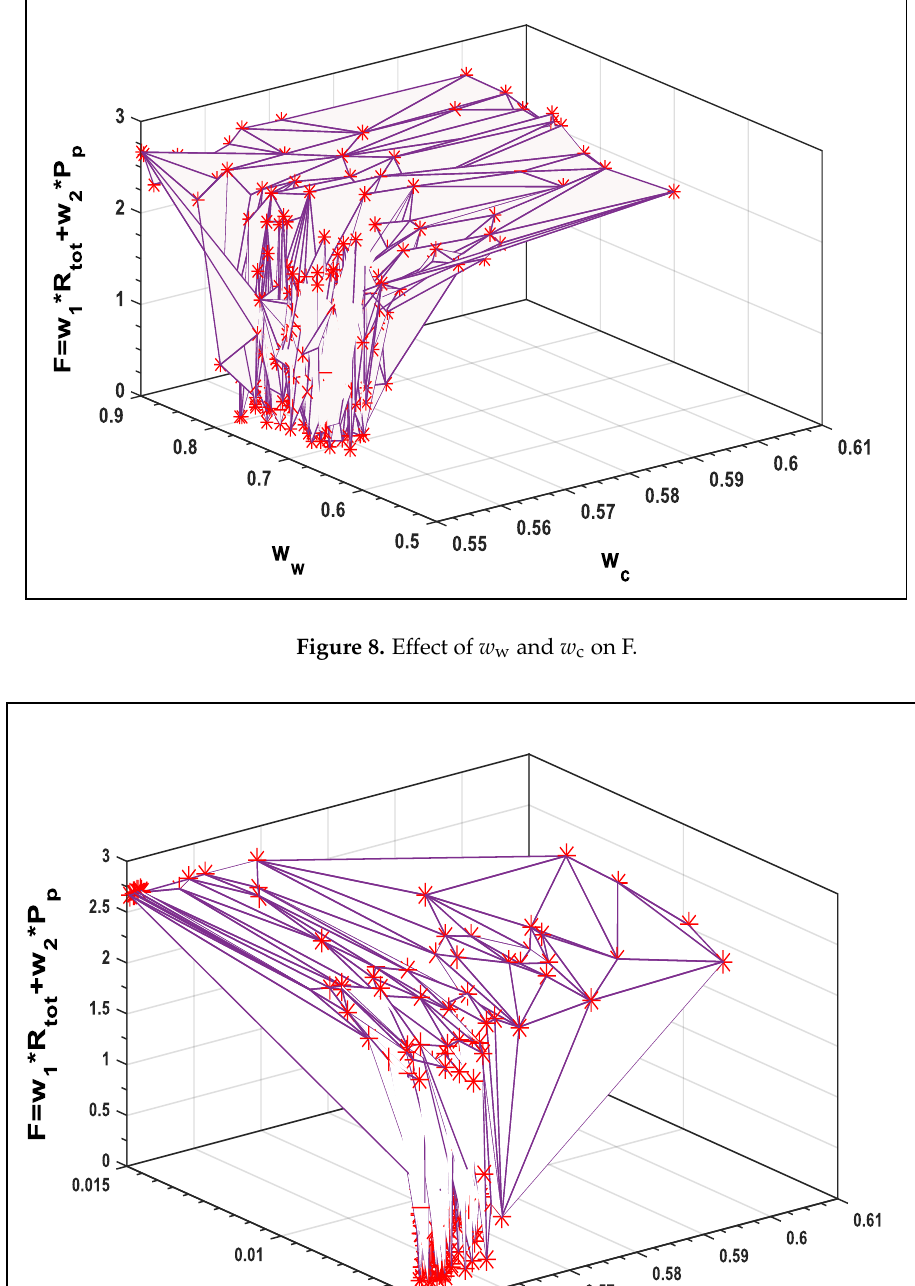
Figure 9. Effect of G and w c on